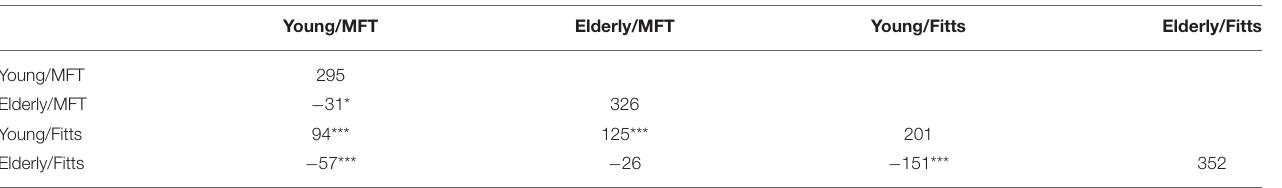
TABLE 3 | Post-hoc comparisons of the fixed-effect three-way